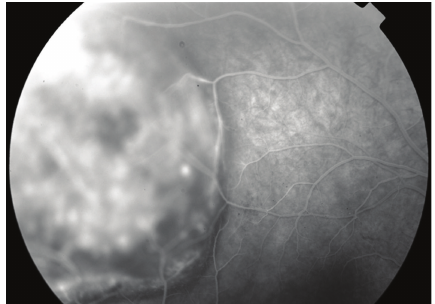
Figure 5: Typical choroidal melanoma with associated nonrheg- matogenous retinal detachment.